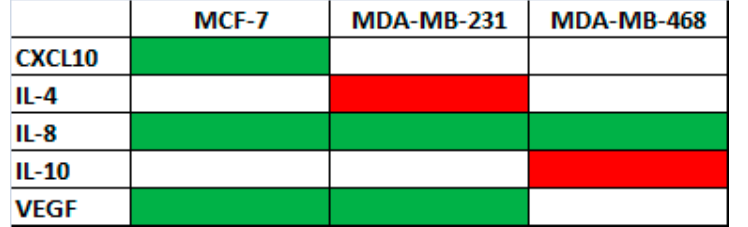
Figure 5. Cytokine levels in breast cancer cells. Scheme reporting the cytokines modulated by the active fraction obtained from the sponge Geodia cydonium . In particular, anti-inflammatory cytokines that are increased after treatment are reported in red and pro-inflammatory and pro-angiogenic cytokines that are decreased after treatment are reported in green. Blank cells indicate that the cytokines are not modulated by active fraction.